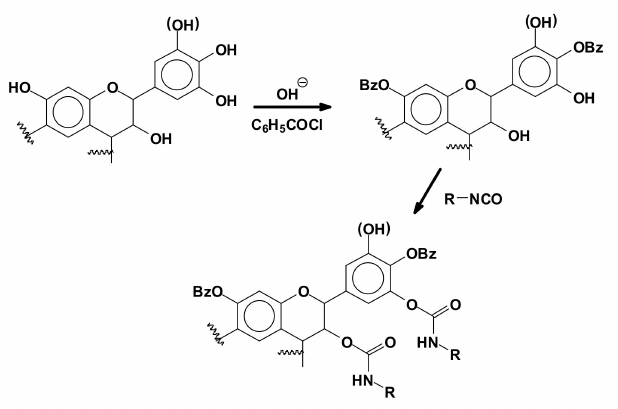
Figure 14. Reaction of a flavonoid tannin modified by benzoylation with an